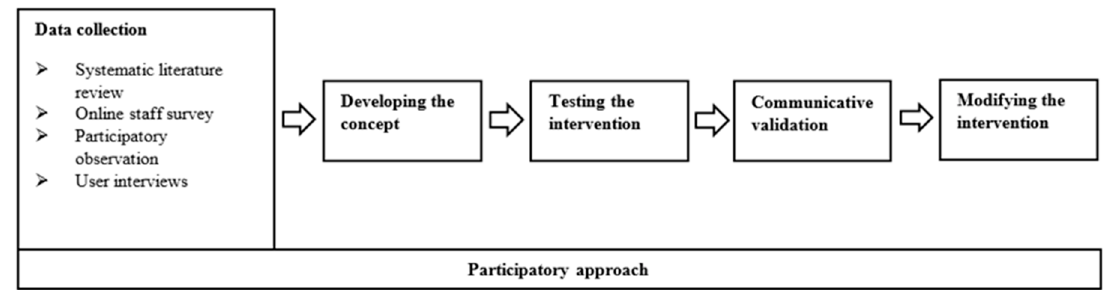
Figure 1. Development process of the physical activity promoting intervention for people with intellectual disabilities.